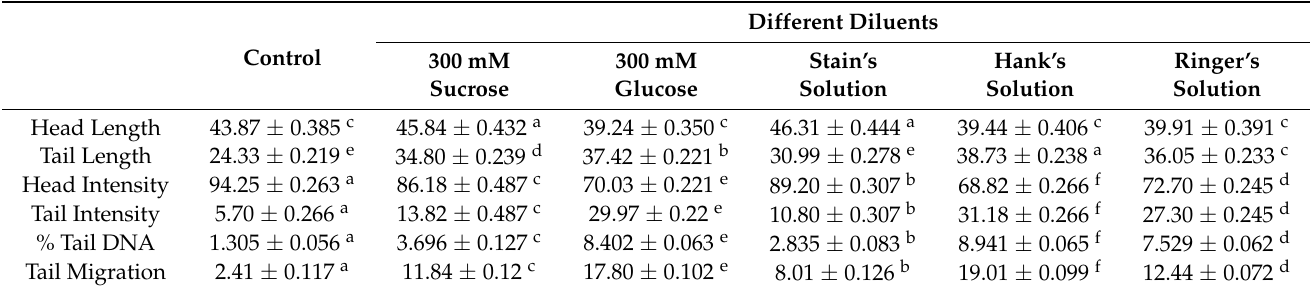
Table 2. Statistical analysis of the comet assay performed after cryopreservation of roughscale sole ( Clidoderma asperrimum ) sperm using various diluents. Different Diluents Control 300 mM Stain’s Hank’s Glucose